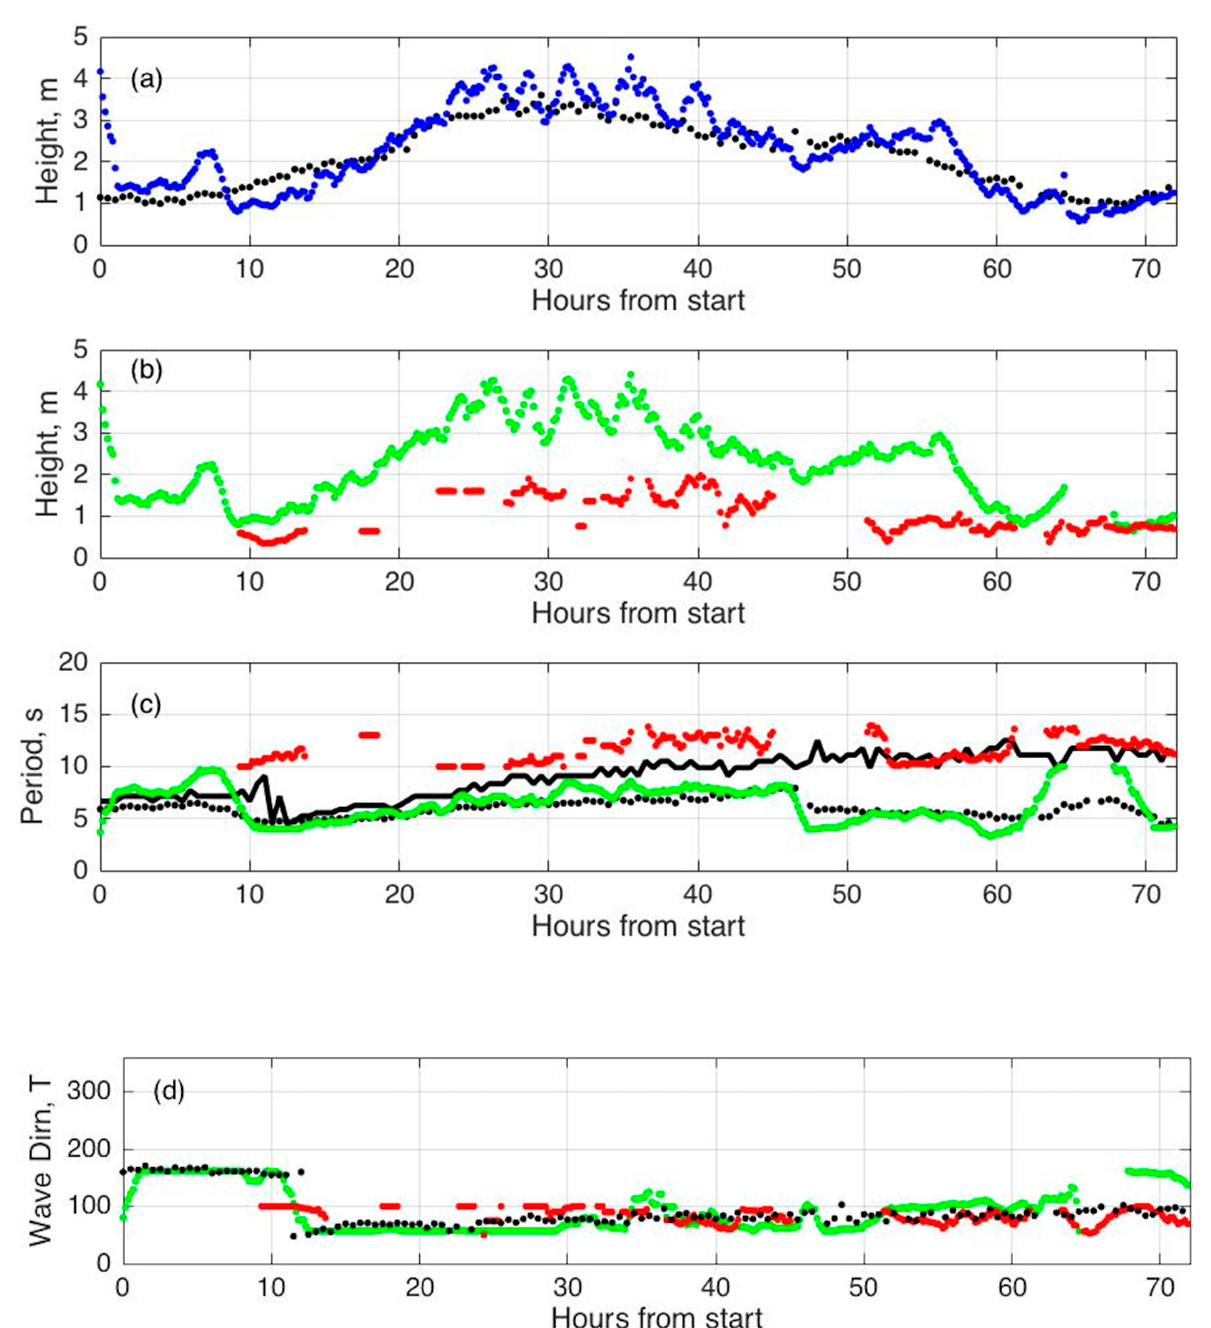
Figure 8. Buoy parameters are plotted in black. Radar parameters are plotted as follows: ( a ) Total waveheight: Radar (blue) ( b ) Waveheight: Wind-wave (green), Swell (red) ( c ) Wave period: Wind-wave (green), Swell (red) ( d ) Wave direction: Wind-wave (green), Swell (red). In ( c ) the upper black line represents the dominant wave period; the lower black line represents the average wave period. In ( d ) the black line represents the direction of the waves at the dominant period. Start time: 12:00 a.m., 29 January 2018.